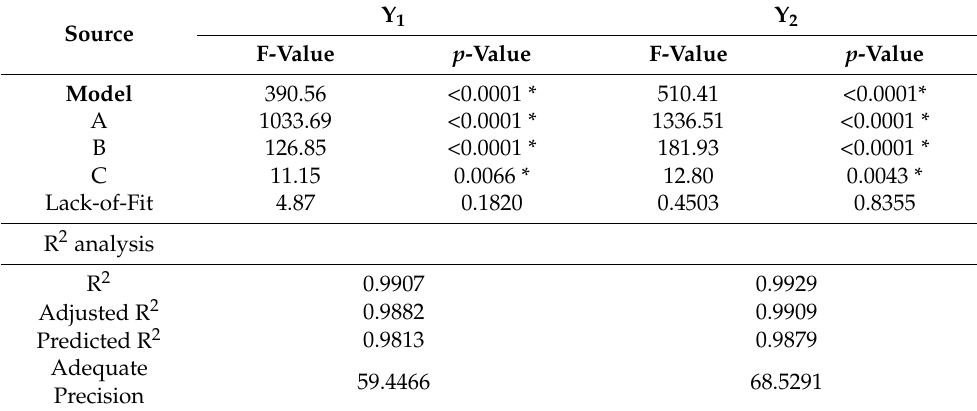
Table 3. Statistical analysis of model and fit statistic for all